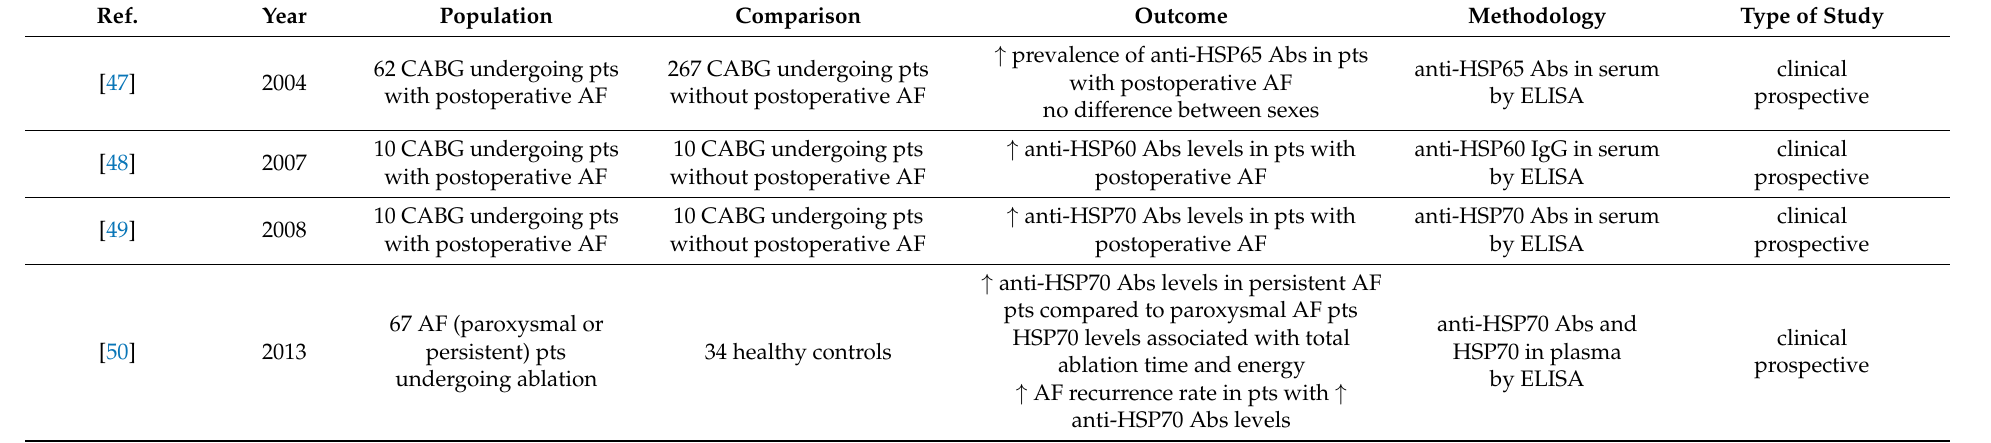
Table 4. Summary of recent research investigating antibodies against heat shock proteins.